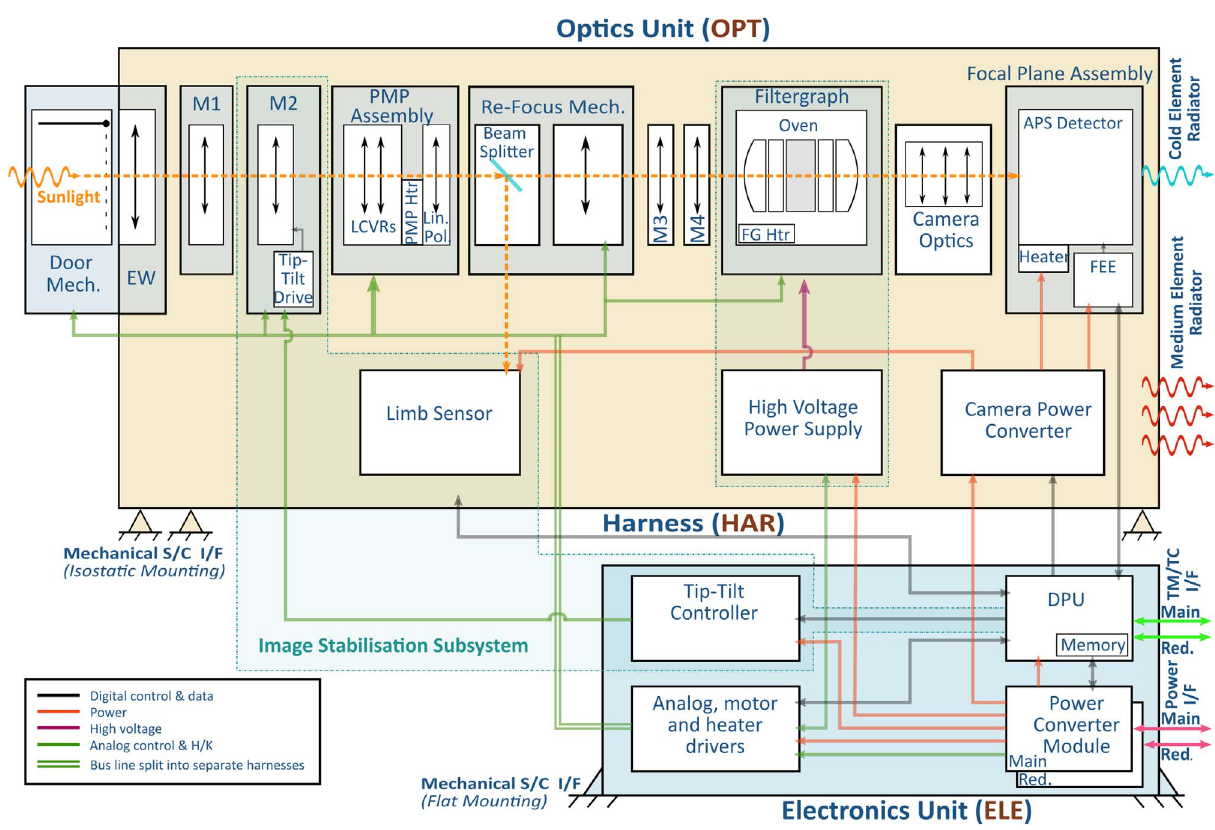
Fig. 5. Schematic overview of the PMI units and functional blocks (EW: entrance window, PMP: polarization modulation package, FEE: front end electronics).